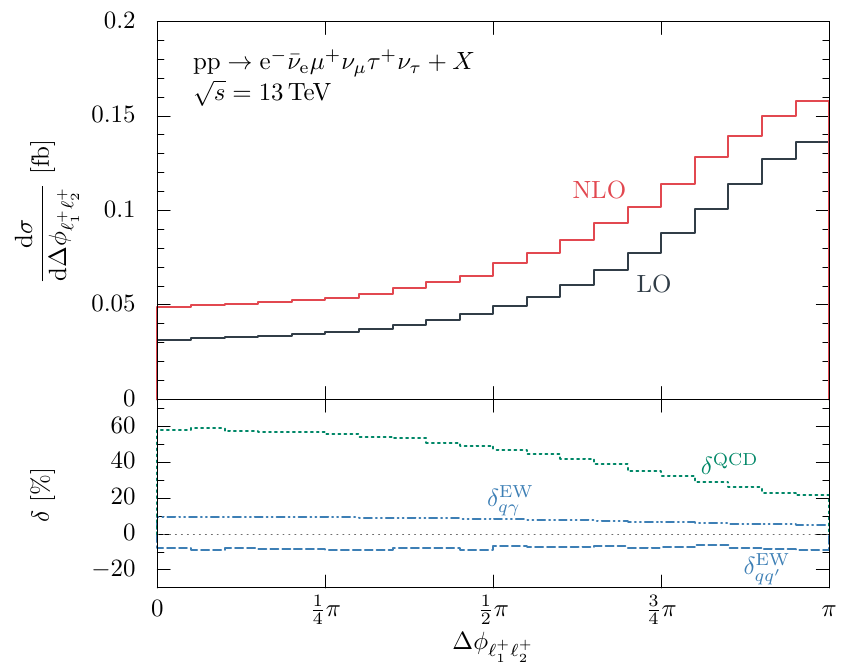
Figure 9. Di(cid:11)erential LO and NLO cross section and relative NLO corrections in the di(cid:11)erence in the azimuthal angle of the two positively charged leptons, (cid:1) (cid:30) distort the shape of the di(cid:11)erential distribution in the di(cid:11)erence of the azimuthal angle of the two positively charged leptons, (cid:1) (cid:30) corrections amount to nearly 60% in the low-(cid:1) (cid:30) region, while in the high-(cid:1) (cid:30) region the correction is only about 20%. We attribute this enhanced impact of QCD corrections again to the recoil of the leptons in the case of hard jet emission, which reduces the angles between the leptons by a strong boost transverse to the beams. We observe that the quark-antiquark-induced EW corrections (cid:14) EW in the pseudorapidities of the two positively charged leptons, (cid:1) (cid:17) corrections somewhat distort the shape of the